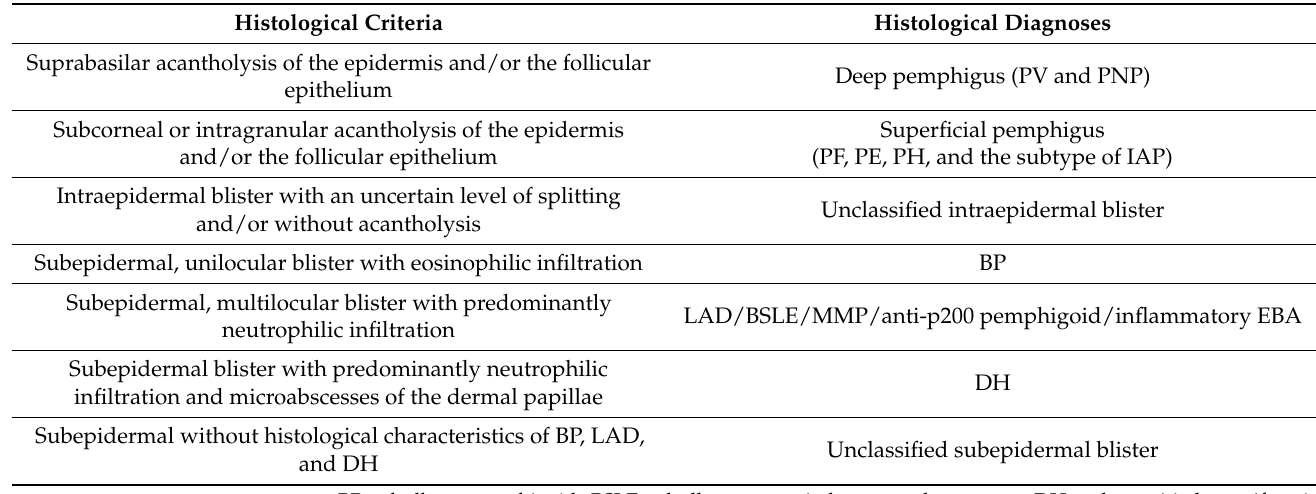
Table 1. Criteria For the Histological Diagnosis of Autoimmune Bullous